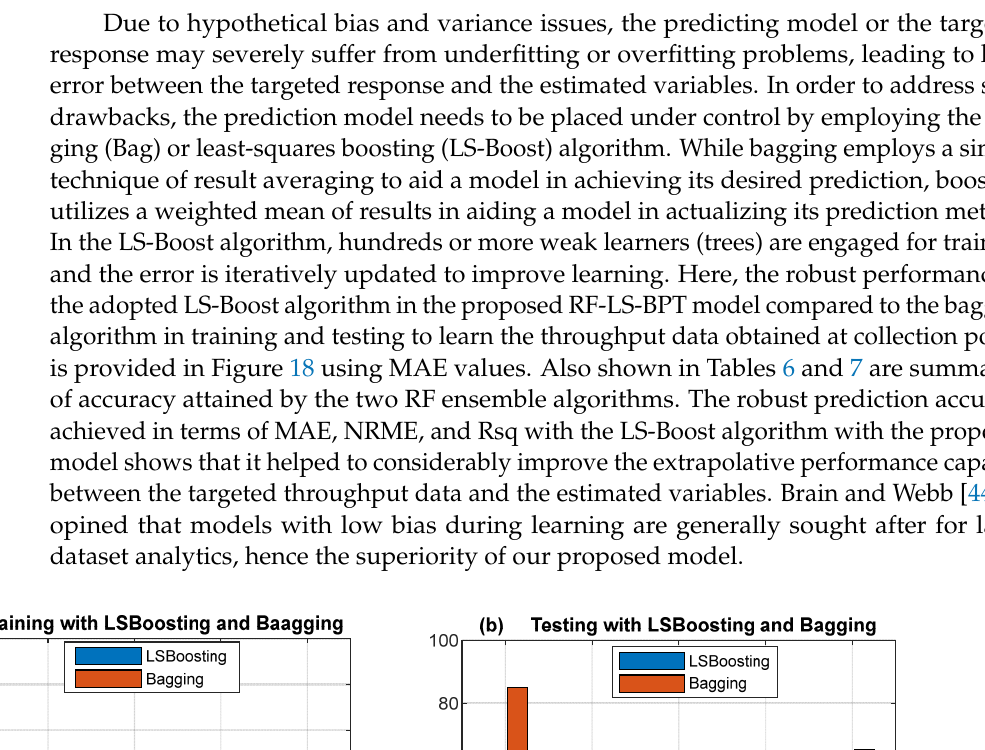
Table 7. Throughput data testing accuracy using LS-Boosting and bagging. Accuracy